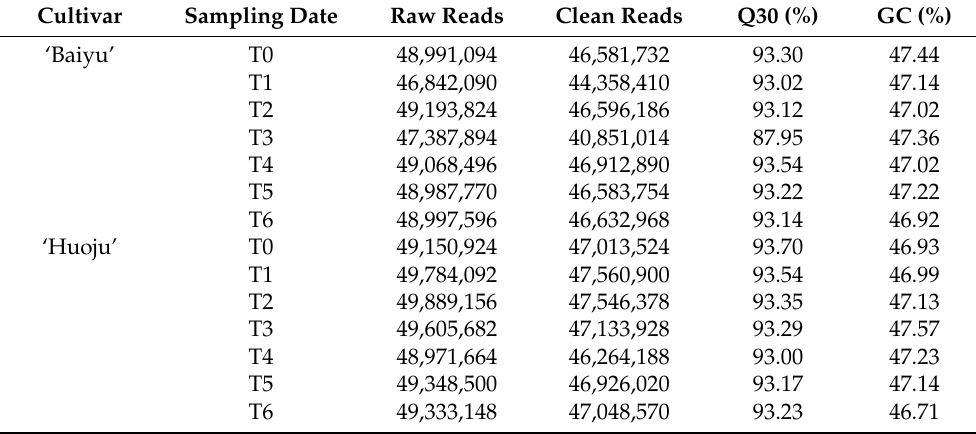
Table 1. IIIumina transcriptomes of apical buds during loquat flower bud differentiation.